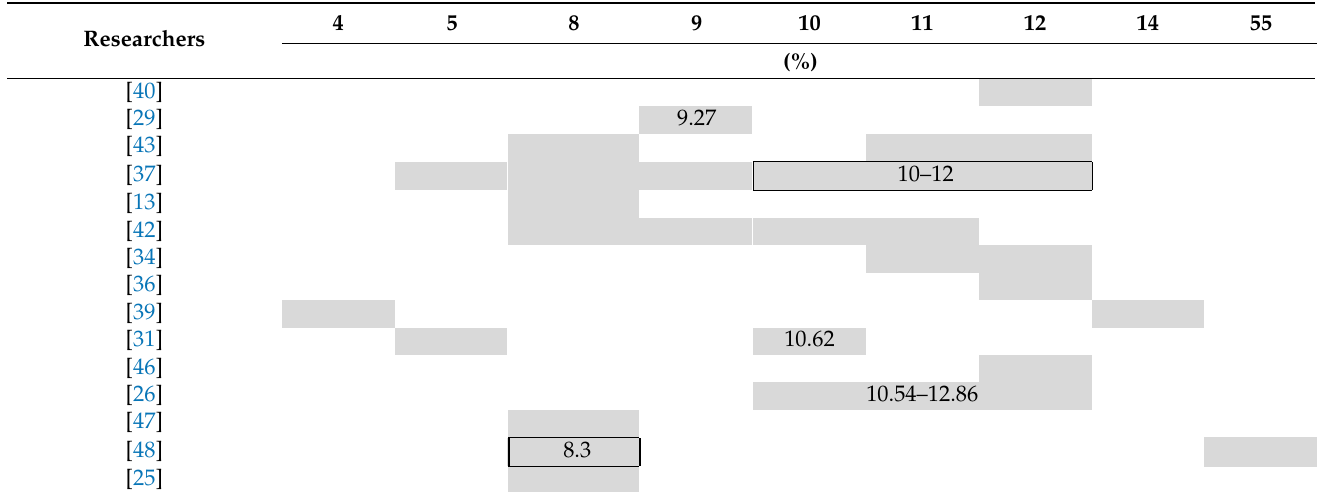
Table 7. Biomass moisture levels for the briquetting